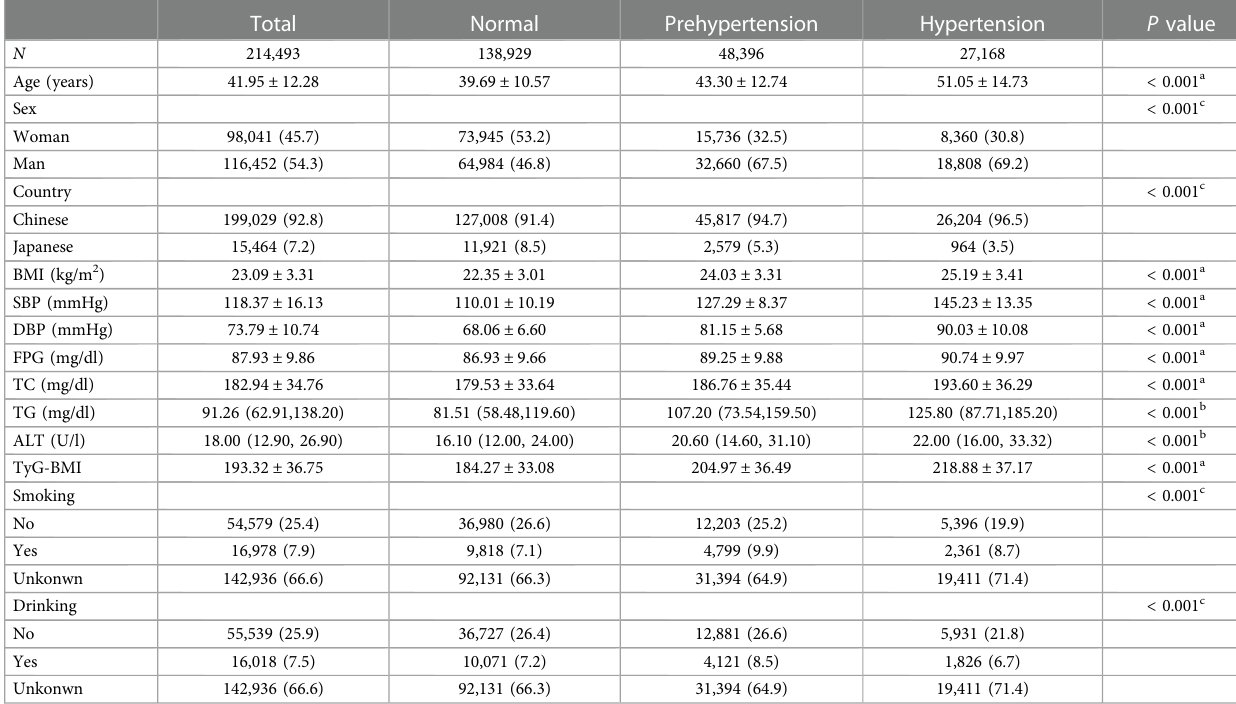
TABLE 1 Baseline Characteristics of study population.